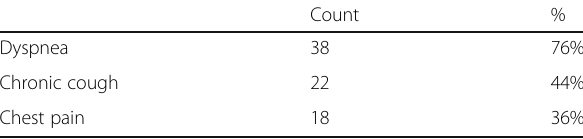
Table 2 Distribution of the chest main symptoms in the studied